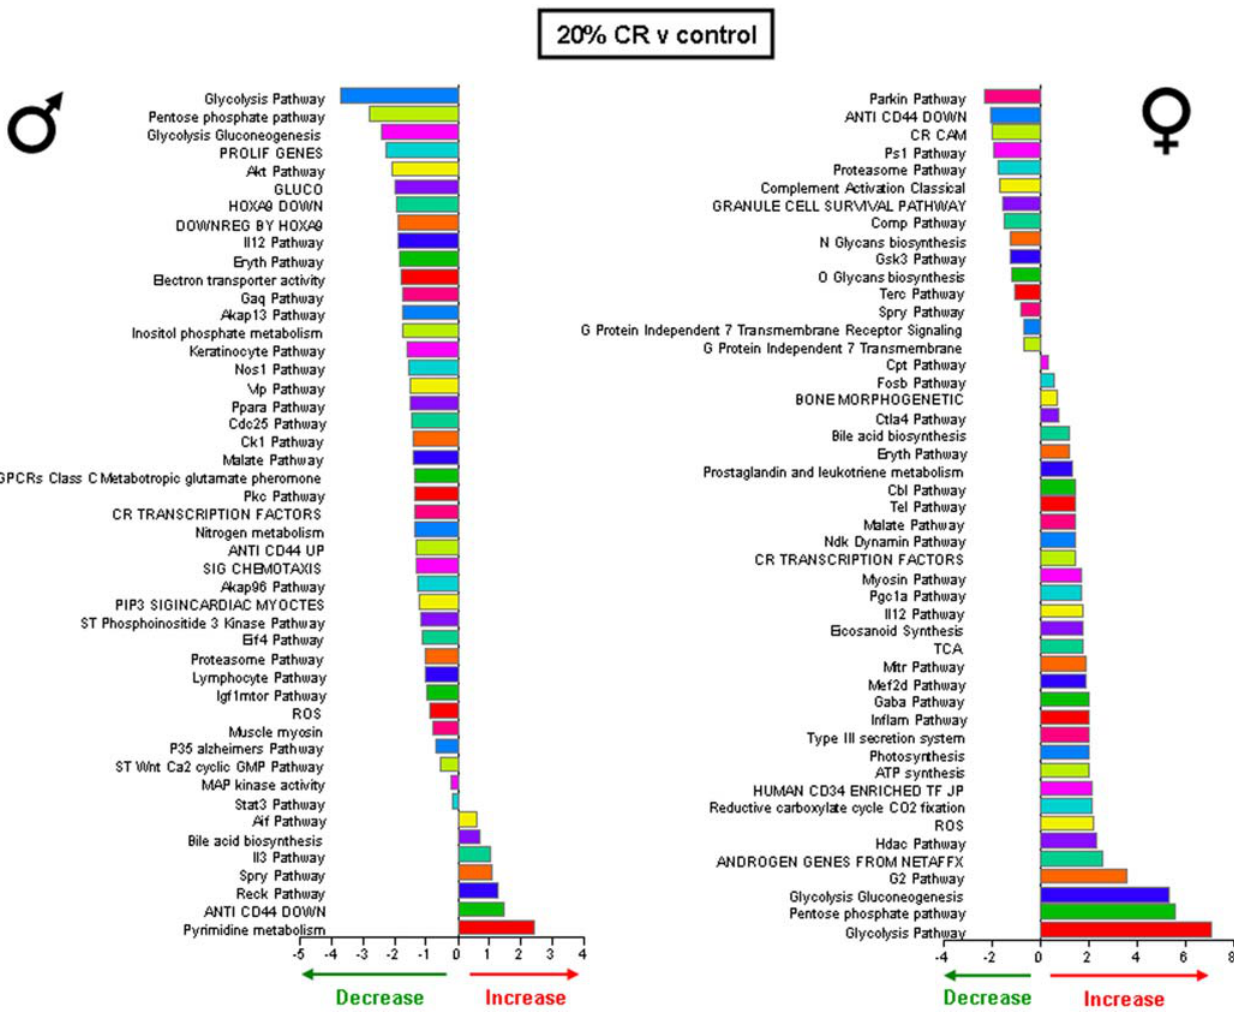
Figure 9. Significant gene pathway changes in the hippocampi of male and female rats maintained on a 20% CR diet. Significantly altered genes in the male and female hippocampi from the different dietary regimes were clustered into functional gene pathways. In the hippocampi from male rats on the 20% CR diet, there were 47 significantly altered gene pathways, of which 40 pathways were significantly down- regulated and 7 pathways were significantly up-regulated, compared to gene pathways in hippocampi from male control rats. Interestingly, the hippocampi from female rats on the 20% CR diet showed a very different functional gene pathway pattern as there were 48 significantly altered pathways, of which 15 were significantly down-regulated and 33 were significantly up-regulated, compared to gene pathways in hippocampi from control female rats.